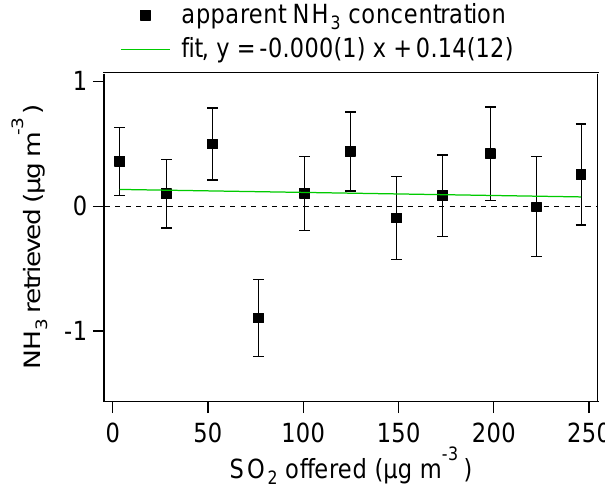
Fig. 11. Results of the SO 2 interference test for the RIVM DOAS instrument.